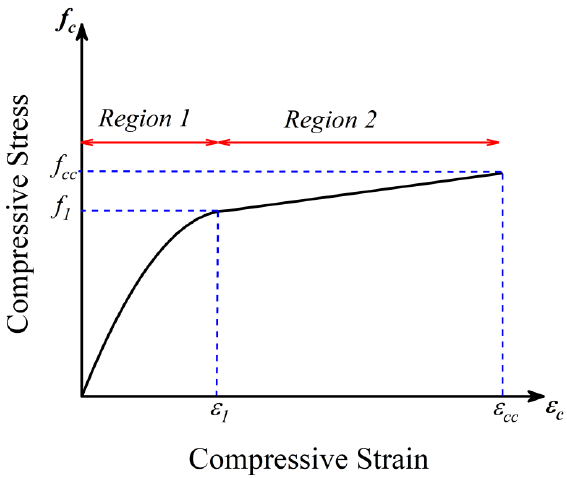
Figure 18. Idealization of compressive stress vs. strain response of hemp-confined concrete.